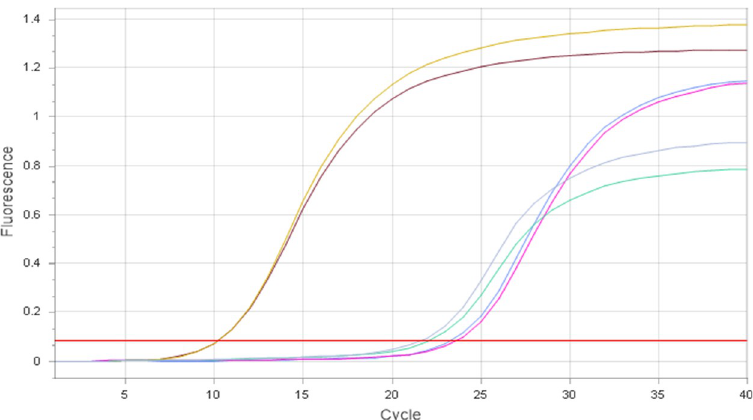
Fig 6. Amplification curves of E . coli DNA: (1) from viable (live) cells (10.5 Cq); (2) from cells killed with Ecas4 at 5%, without PMA treatment (22.0 Cq); (3) from dead E . coli control treated with 50 μ M PMA (23.7 Cq–Aliquot of 500 μ L killed by boiling at 85˚C for 15 min). All qPCR tests were performed using universal bacterial primers at 0.75 nM.